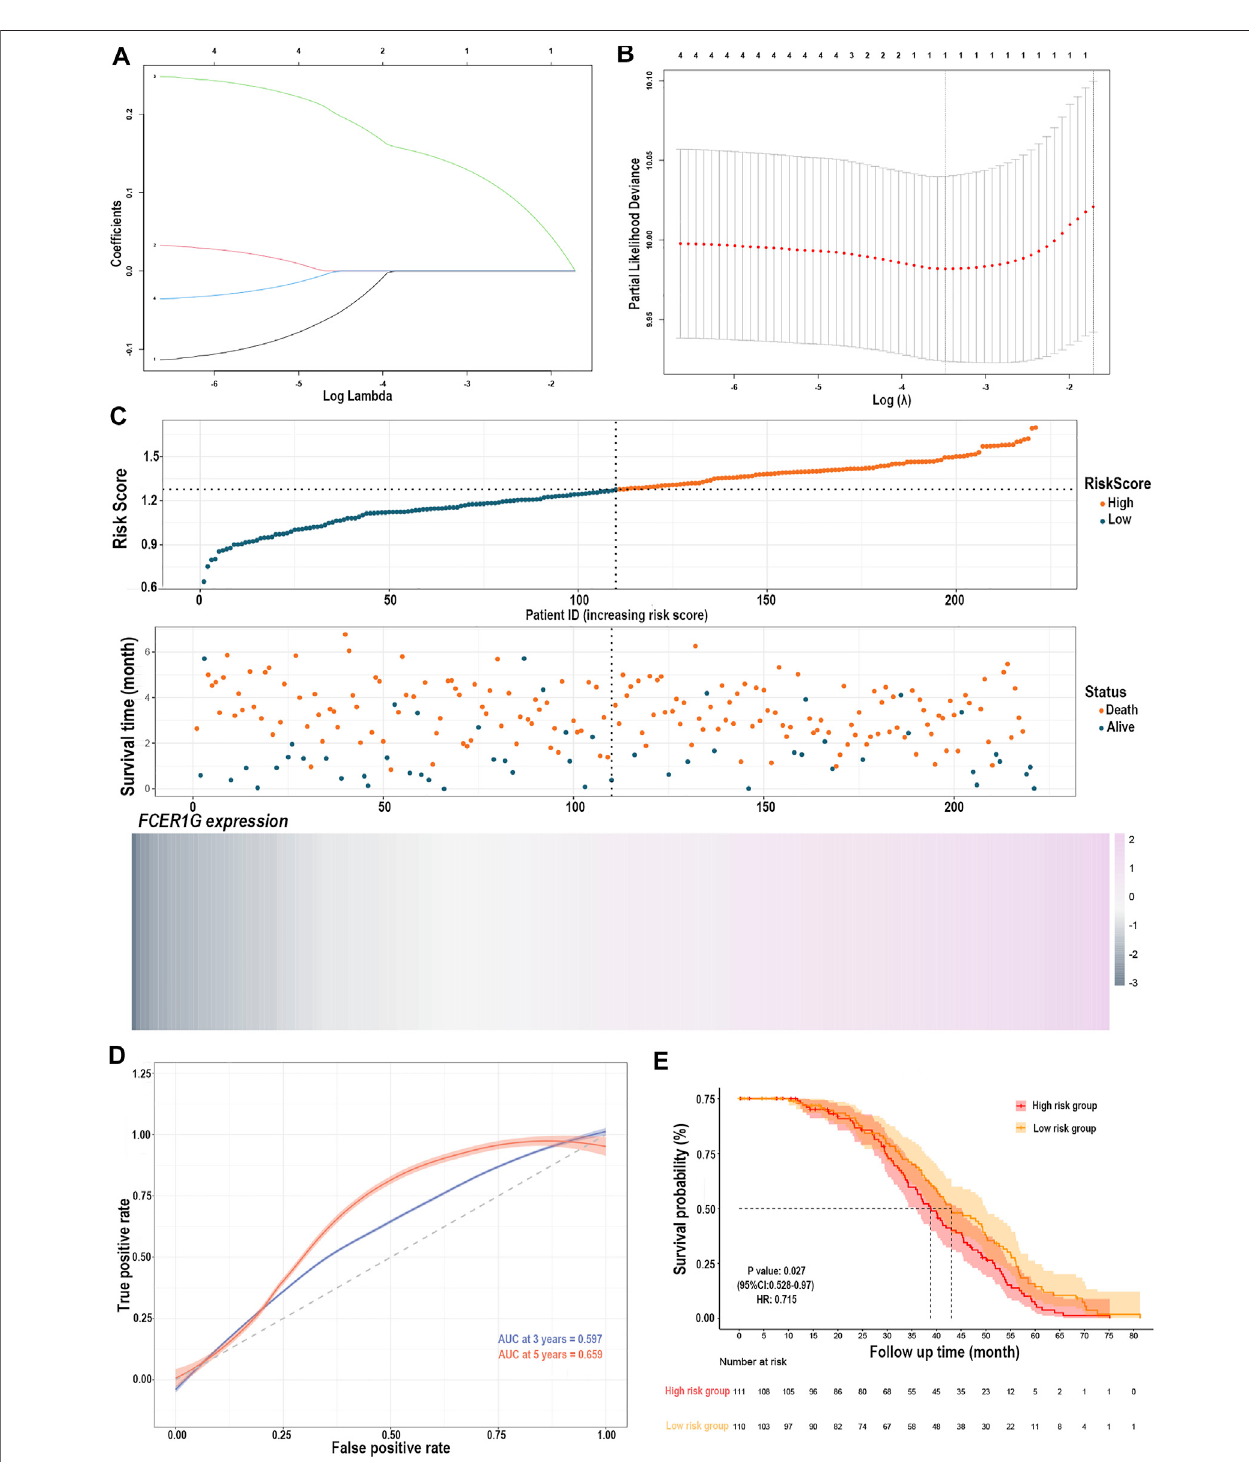
FIGURE 7 | Construction of the risk prediction model. (A) The path change chart of the regression coef fi cient. (B) The change curve of penalty term. (C) The distribution of risk scores, the survival status of patients, and the expression level in screening single gene. (D) The time-dependent ROC curve and AUC of the single- gene signature. (E) Kaplan-Meier plots of overall survival between high- and low-risk groups in the testing group by the log-rank test. LASSO, least absolute shrinkage and selection operator; ROC, receiver operating characteristic curve; AUC, an area under the curve.